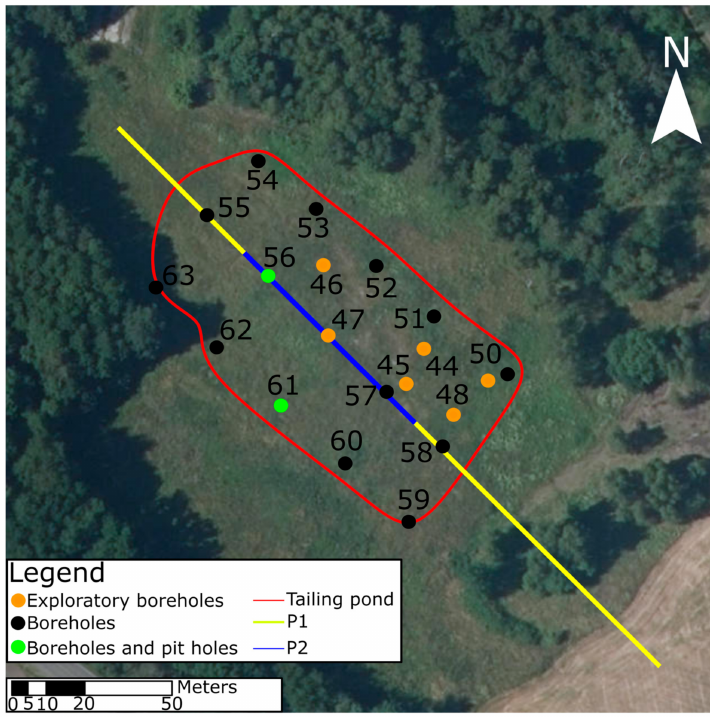
Figure 2. Map of the Plombi è res site, showing the orientation of the profiles studied with geophysics. The yellow line represents the short profile, and the blue line the long profile [38]. The red line represents the studied area of the tailings pond. The map also shows the sampling points. Orange dots represent the points where exploratory boreholes were made. Black dots represent the points where only drill holes were made, while green dots represent points where both drill holes and pit-holes were made